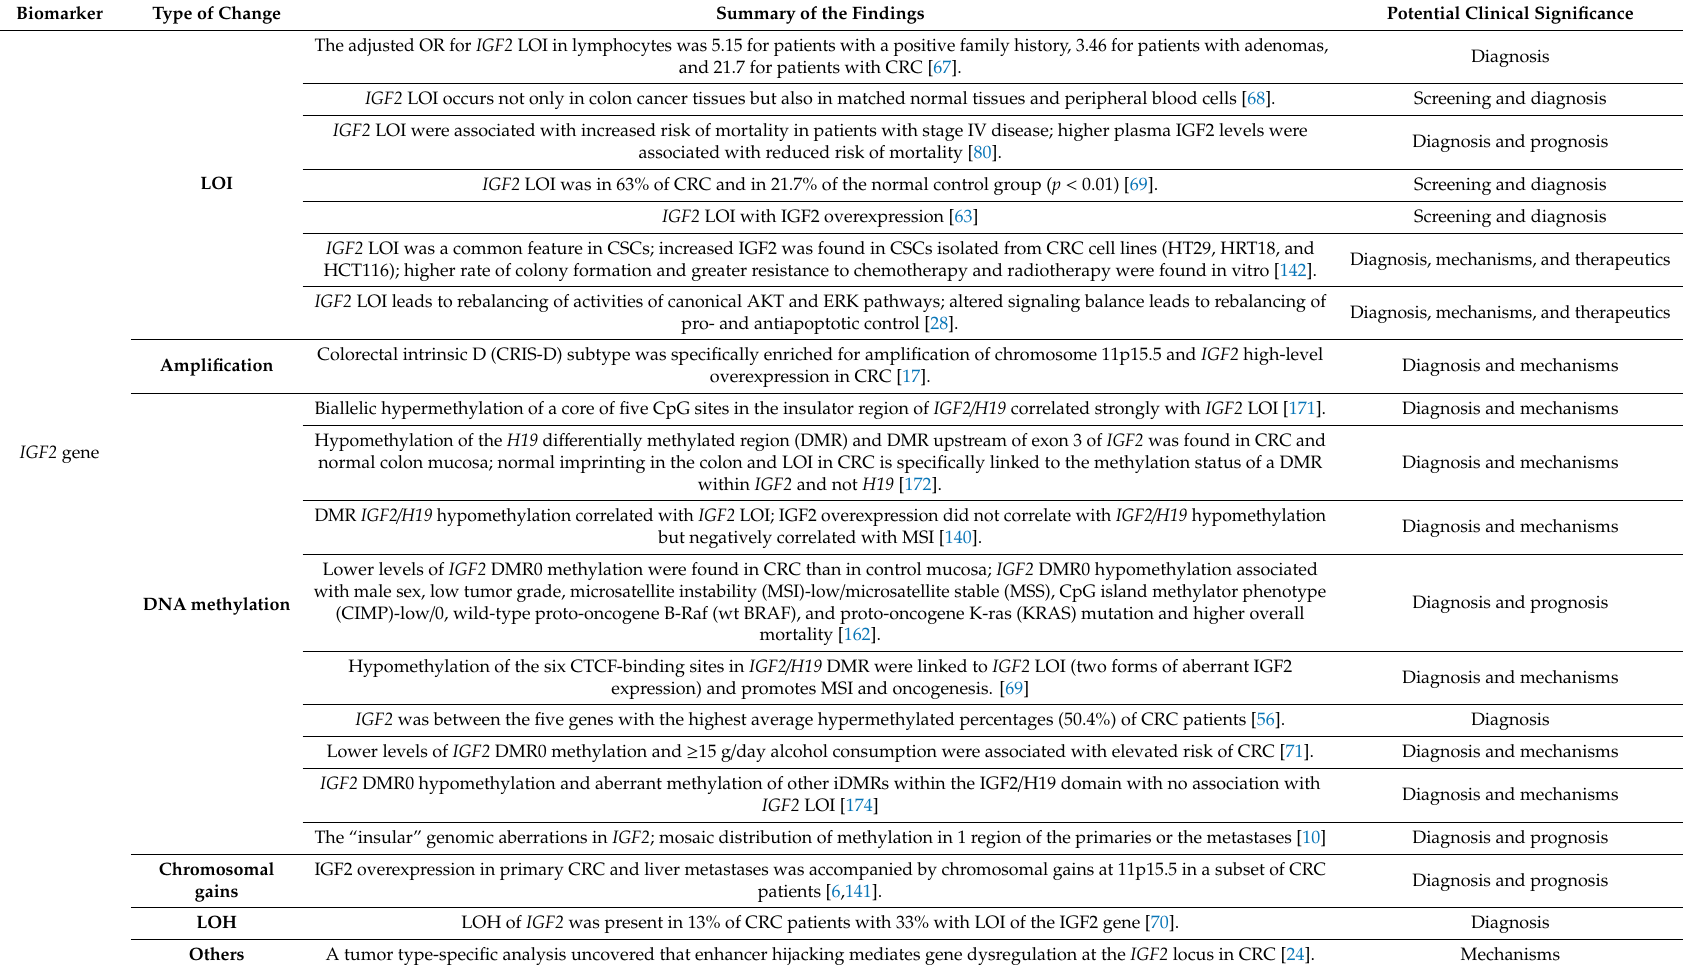
Table 1. Summary of the main genetic and epigenetic changes of IGF2 and IGF2-associated biomarkers in